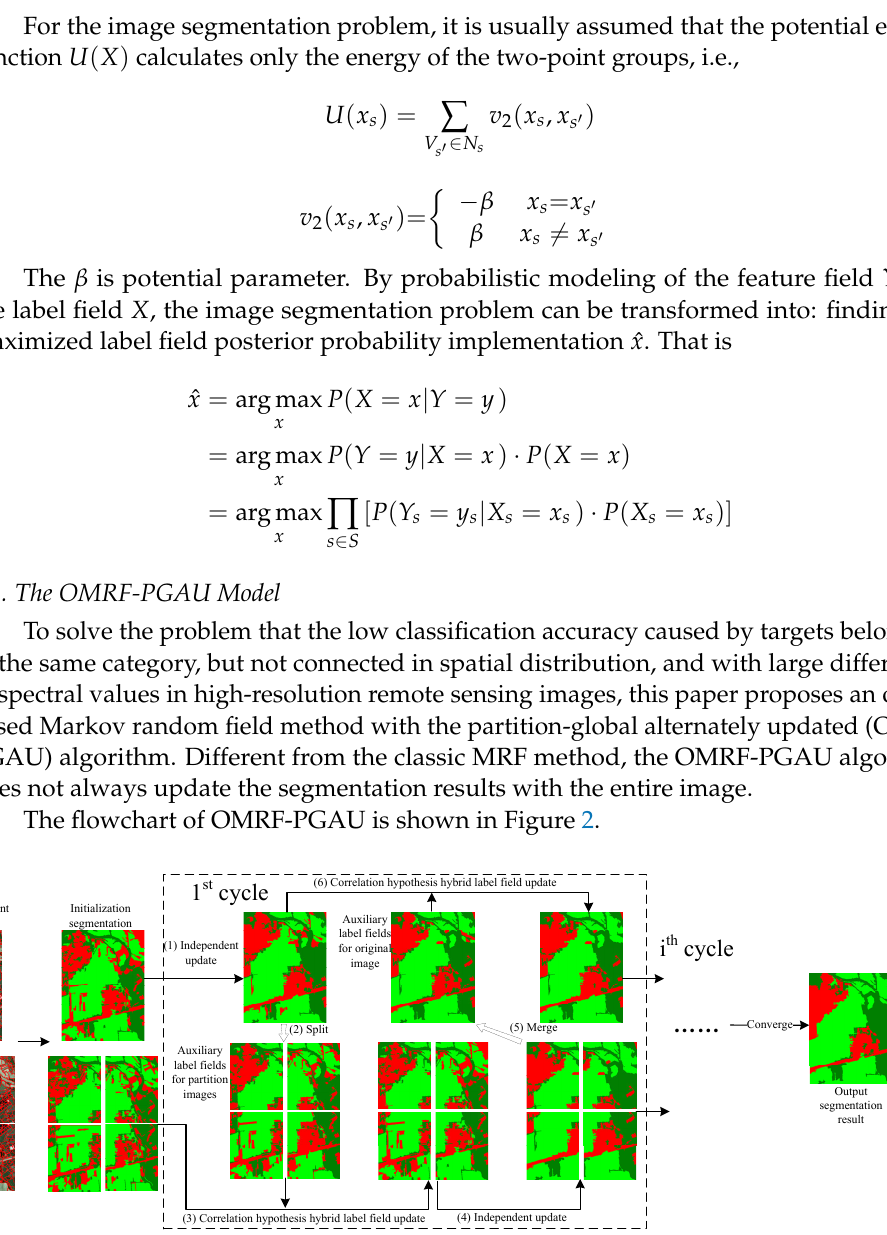
(cid:110) G ( 1 ) , G ( 2 ) , G ( 3 ) , G ( 4 ) (cid:110) X ( 1 ) , X ( 2 ) , X ( 3 ) , X ( 4 )